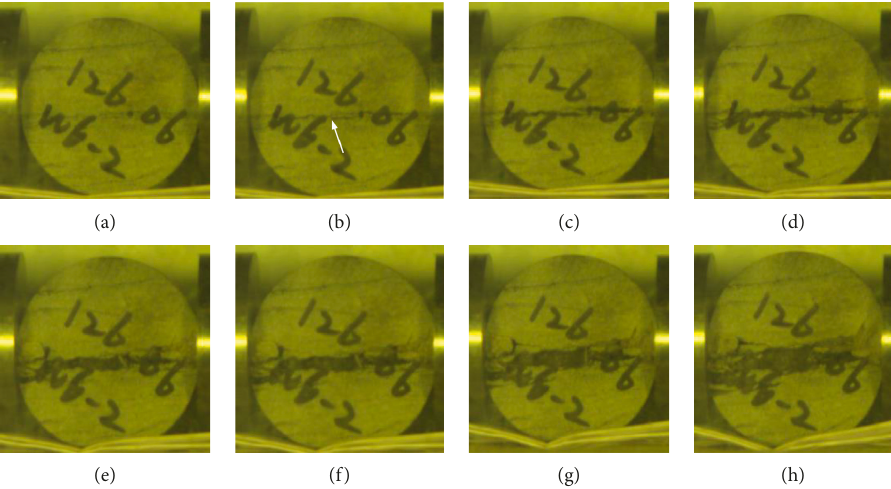
Figure 7: Failure processes of the specimen with a water content of 1.09%: (a) t � 0 μ s; (b) t � 55 μ s; (c) t � 110 μ s; (d) t � 165 μ s; (e) t � 275 μ s; (f) t � 330 μ s; (g) t � 440 μ s; (h) t � 605 μ